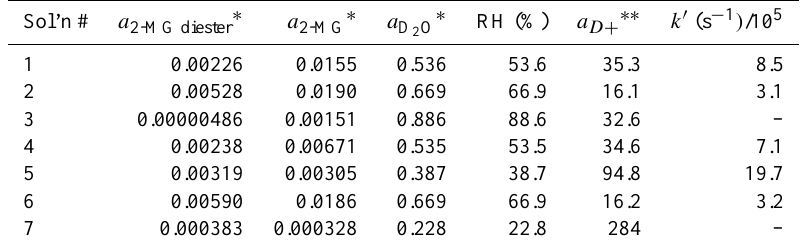
Table 7. Equilibrium activities, calculated using AIOMFAC-web, and kinetics information for perchloric acid controlled composition exper- iments, Solutions 1, 2, 4, 5 and 6. ∗ Activities calculated on a mole fraction basis. ∗∗ Activity calculated on a molality basis.